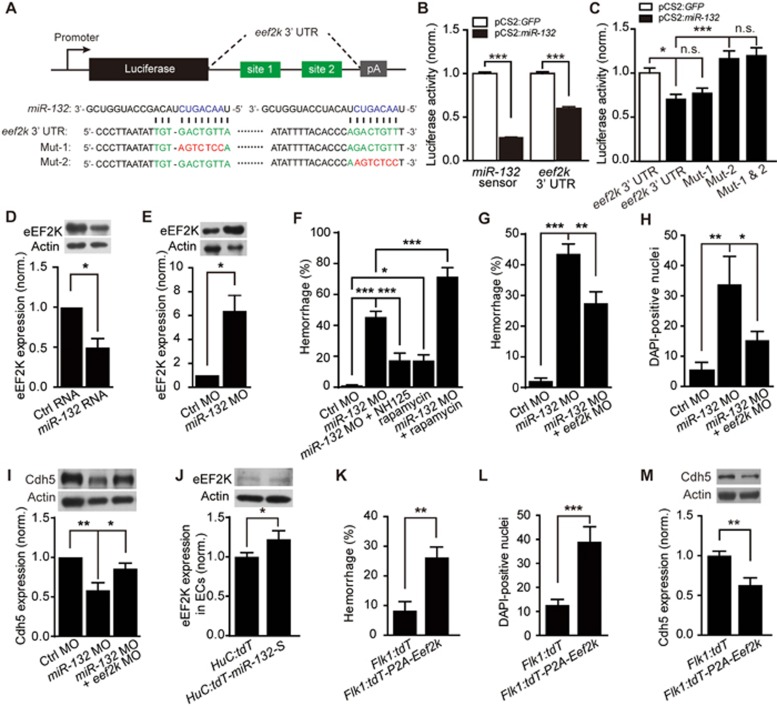
MiR-132 regulates Cdh5 expression and brain vascular integrity by directly targeting endothelial eef2k. (A) Schematic showing two potential miR-132 binding sites (in green) in the eef2k3′ UTR. Two mutants (“Mut-1”, “Mut-2”) of the eef2k3′ UTR were introduced by replacing the wildtype binding sequence (GACTGTT) with a mutant sequence (AGTCTCC, in red) at the two corresponding binding sites. The seed sequence of miR-132 is in blue. (B) Suppression of the luciferase activity of the eef2k3′ UTR reporter in HEK293 cells by miR-132. MiR-132 sensor served as a positive control. The experiments were repeated three times. (C) Requirement of the binding site 2 in the eef2k3′ UTR for miR-132 effect. The experiments were repeated three times. (D, E) Effects of miR-132 overexpression (D) or knockdown (E) on eEF2K expression in zebrafish larvae. The experiments were repeated three times. (F) Pharmacological evidence showing eEF2K mediates the intracranial hemorrhage effect of miR-132 knockdown. NH125, eEF2K inhibitor; rapamycin, eEF2K non-specific activator. The experiments were repeated 5-8 times, and for each time, > 15 embryos were examined for each group. (G-I) Rescue effect of eef2k knockdown on miR-132 knockdown-induced intracranial hemorrhage (G), DAPI leakage in the brain (H) and Cdh5 expression reduction (I) in zebrafish larvae. For G, the experiments were repeated 6-7 times, and for each time, > 53 embryos were examined for each group. For H, 8, 8, and 11 embryos were analyzed for “Ctrl MO”, “miR-132 MO” and “miR-132 MO + eef2k MO”, respectively. For I, the experiments were repeated four times. (J) Effect of neuron-specific miR-132 downregulation on endothelial eEF2K expression in zebrafish larvae. ECs were sorted by flow cytometry from 3-dpf Tg(Flk1:eGFP) larvae, which were injected with HuC:tdT or HuC:tdT-miR-132-S plasmid. The experiments were repeated three times. (K-M) Effects of EC-specific Eef2k overexpression on intracranial hemorrhage (K), DAPI leakage in the brain (L), and Cdh5 expression (M) of zebrafish larvae. The Eef2k was cloned into Flk1:tdT-P2A vector (“Flk1:tdT-P2A-Eef2k”). Expression of tdT in ECs (“Flk1:tdT”) served as a control. For K, the experiments were repeated nine times, and for each time, > 5 embryos were examined for each group. For L, 12 and 13 embryos were analyzed for “Flk1:tdT” and “Flk1:tdT-P2A-Eef2k”, respectively. For M, the experiments were repeated six times. Error bars, SEM. n.s., no significant; *P < 0.05, **P < 0.01, ***P < 0.001 (unpaired two-tailed Student's t-test for B, D, E, J-M; one-way ANOVA with post hoc Tukey's multiple comparison test for C and I; one-way ANOVA with post hoc Bonferroni's multiple comparison test for F, G and H).